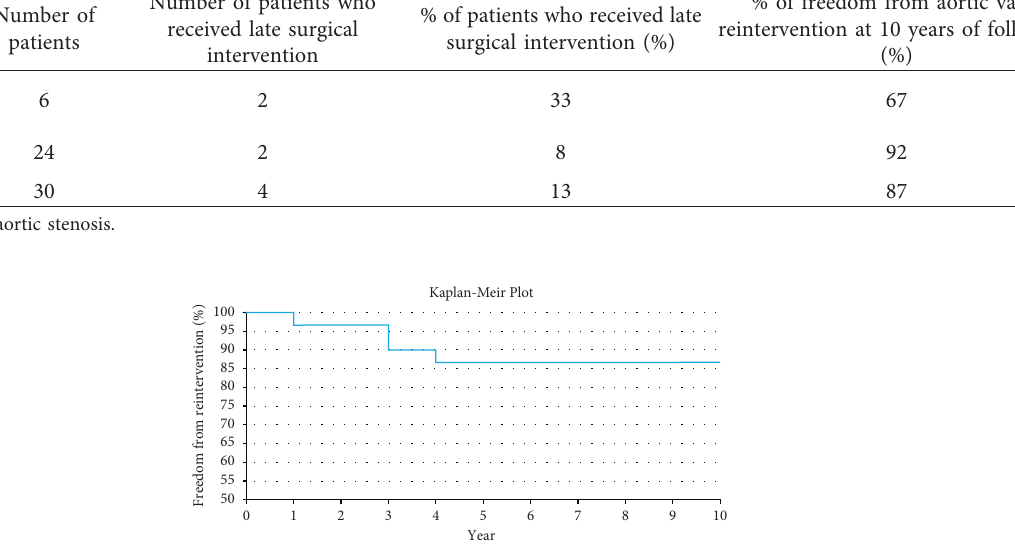
Figure 5: Graph showing the Kaplan–Meier survival free from aortic valve reintervention computed over a follow-up period of 10